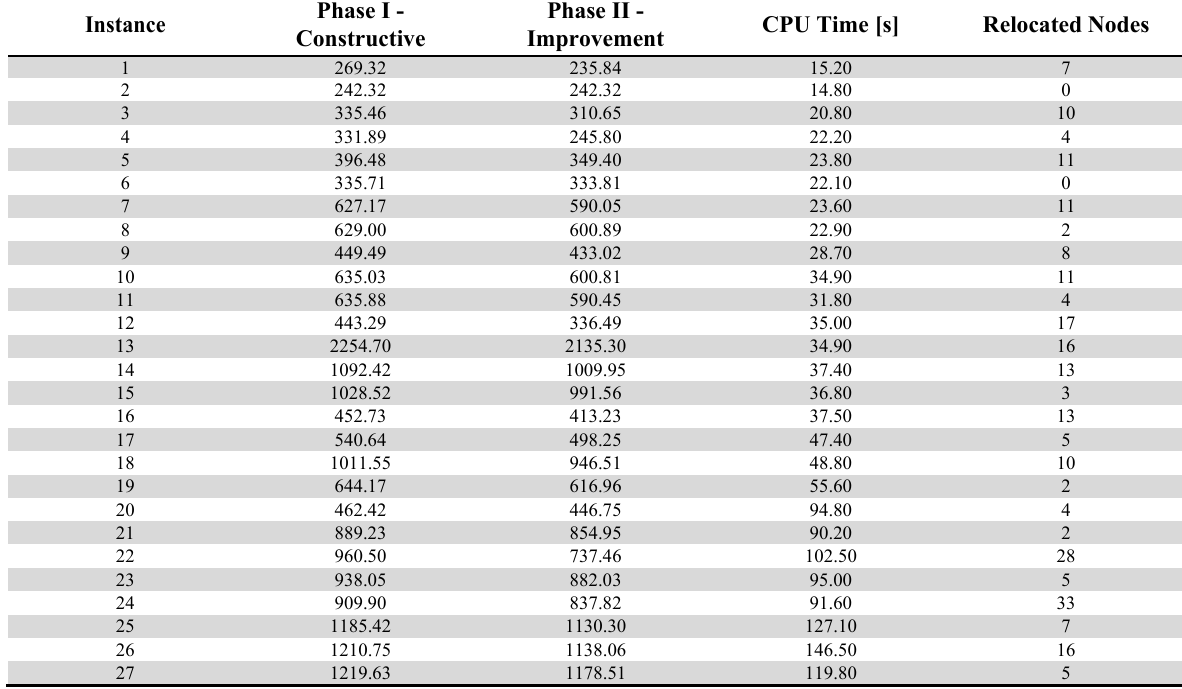
Performance of algorithm without packing constraints